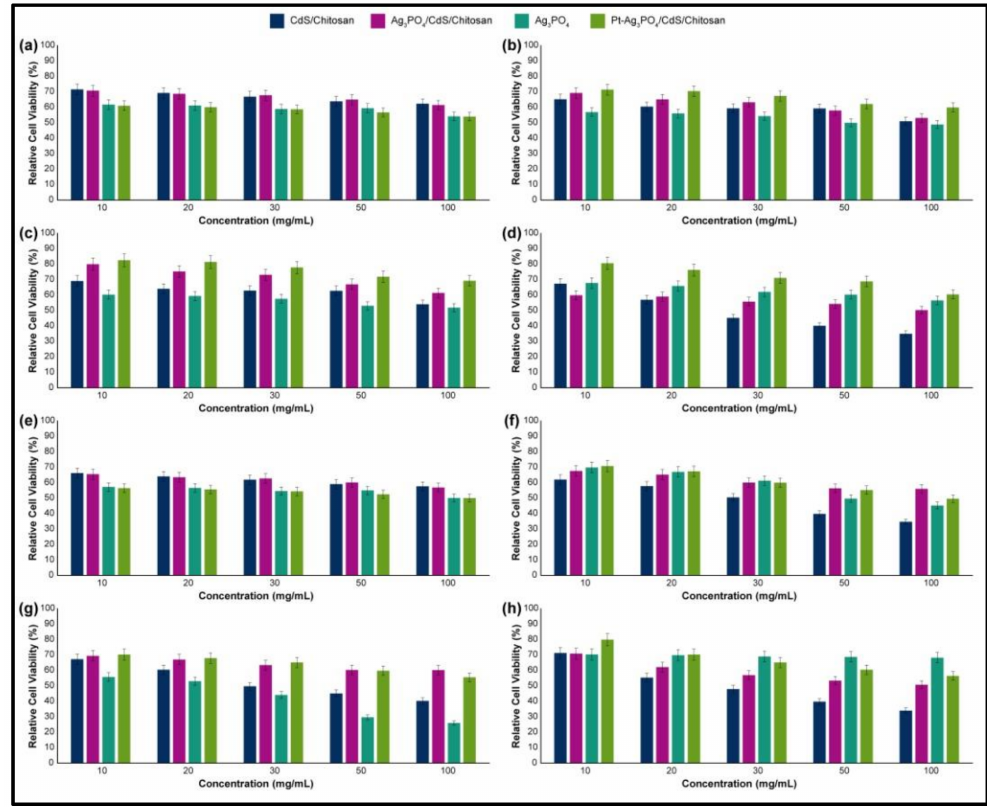
Figure 11. MTT results of the CdS / Chitosan, Ag 3 PO 4 / CdS / chitosan, Ag 3 PO 4 , and Pt-Ag 3 PO 4 / CdS / chitosan on ( a ) HEK-293, ( b ) HeLa, ( c ) HepG2, and ( d ) PC12 cell lines after 24 h of treatment; and on ( e ) HEK-293, ( f ) HeLa, ( g ) HepG2, and ( h ) PC12 after 48 h of